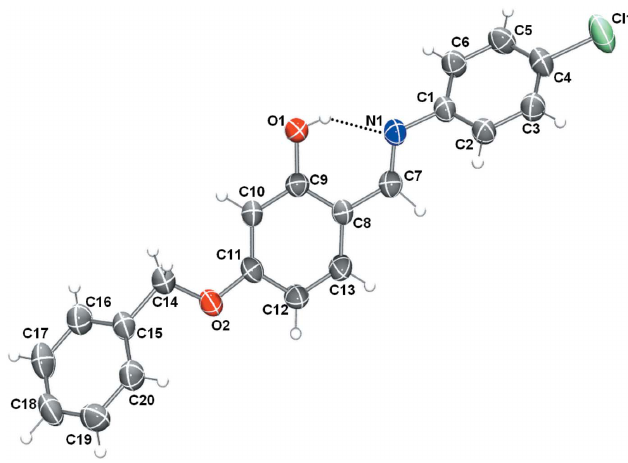
Figure 1 View of the molecular structure of compound (I), with the atom labelling. Displacement ellipsoids are drawn at the 50% probability level. The intramolecular O—H (cid:2)(cid:2)(cid:2) N hydrogen bond (see Table 1) is shown as a dashed